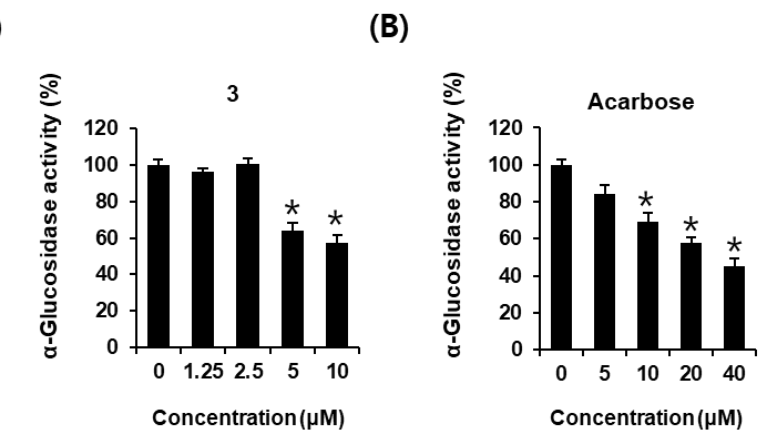
Figure 5. α -Glucosidase-inhibitory activities of ( A ) AEA ( 3 ) and ( B ) acarbose (positive control) compared with that of the control (0 µ M) by α -glucosidase-inhibitory activity assay ( n = 3 independent experiments, * p < 0.05, Kruskal – Wallis nonparametric test). Data are expressed as the mean ± SEM.